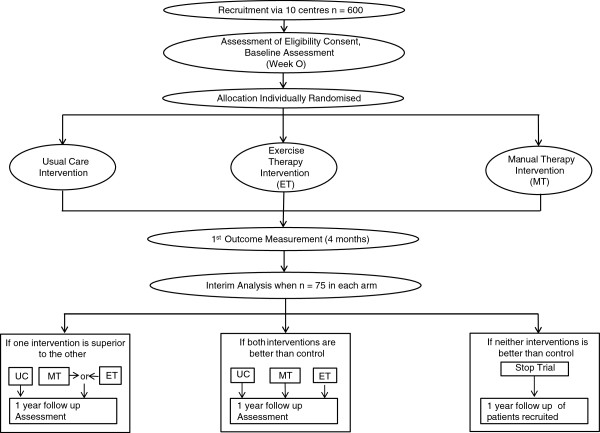
Study flow chart.